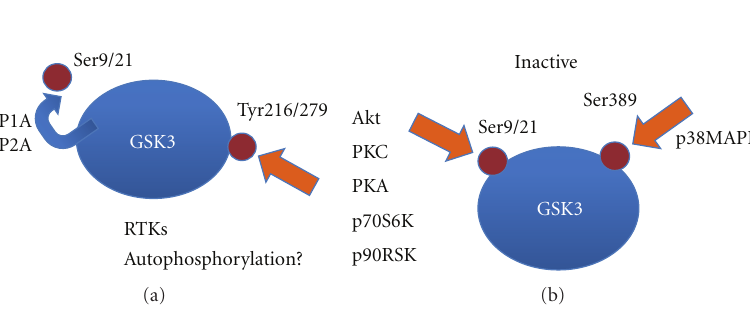
Figure 1: Modulation of GSK3 activity by phosphorylation. Protein phosphatases 1 and 2A activate GSK3 by removing Ser9/21 phosphorylation. It has also been reported that phosphorylation in tyrosine residues by members of the receptor tyrosine kinase family of cell surface receptors (RTKs) or by autophosphorylation may activate GSK3. On the other hand, signaling networks activate several protein kinases, which may bring about phosphorylation of di ff erent residues and inhibition of GSK3.